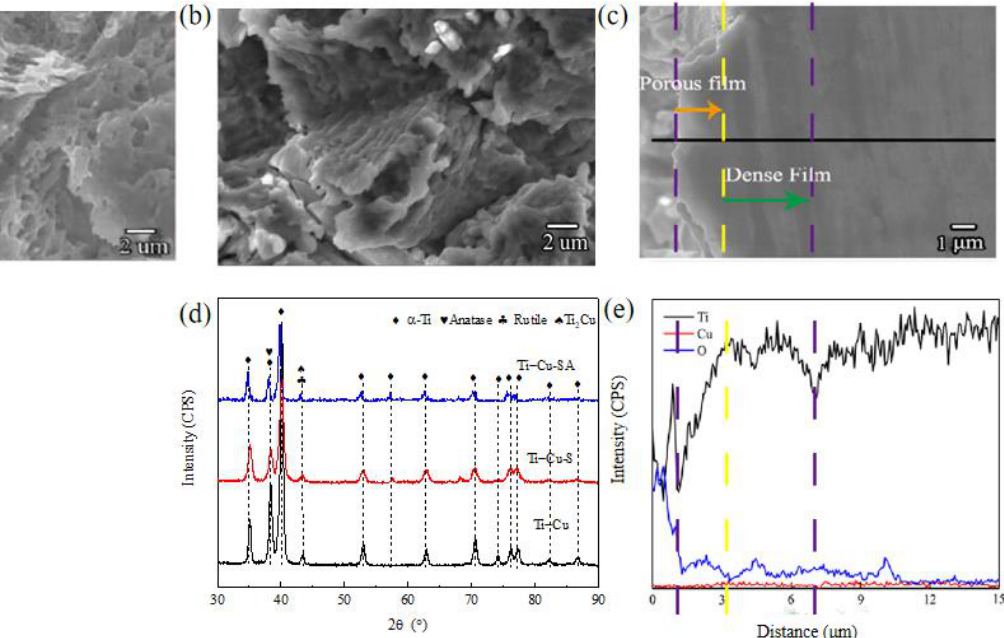
Figure 1. SEM morphology, film thickness and phase composition of surface-modified samples ( a ) SEM morphology of Ti-Cu-S after 15 min of acid etching at a voltage of 60 V; ( b ) SEM morphology of Ti-Cu-SA after 10 min at an oxidation voltage of 60 V; ( c ) SEM morphology of Ti-Cu-SA; ( d ) XRD patterns; ( e ) cross-sectional microstructure of Ti-Cu-SA.